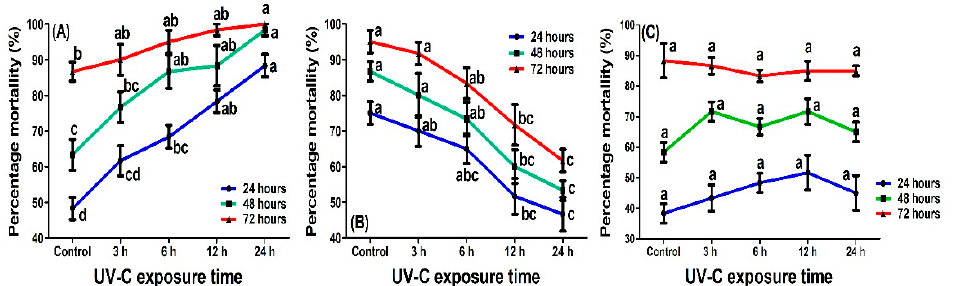
Figure 6. Mortality percentage of third instar larvae of Plutella xylostella exposed to UV-C radiation ( A ) First UV − C radiation then Cordyceps fumosorosea treatment; ( B ) First C. fumosorosea treatment then UV-C radiation; ( C ) Dead insects from ( B ) collected, F1 fungal generation regrown and virulence checked again. Each bar shows the mean value of four replications, and error bars indicate the mean deviation. Lowercase letters indicate a significant difference among the treatments at P < 0.05, and similar letters have no significant difference among treatments.